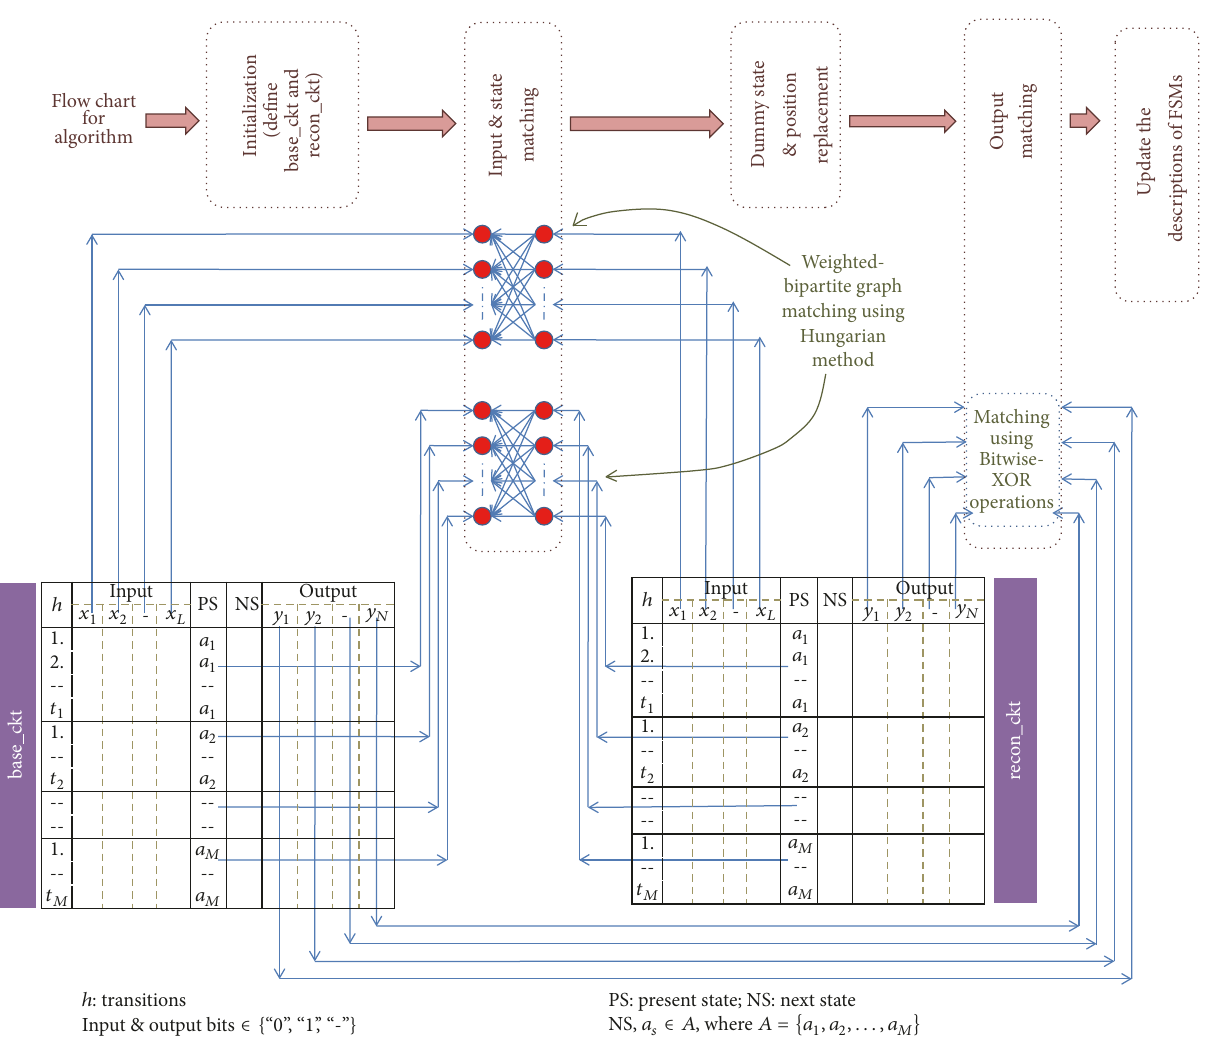
Figure 2: Flow chart for iterative greedy heuristic based Hungarian